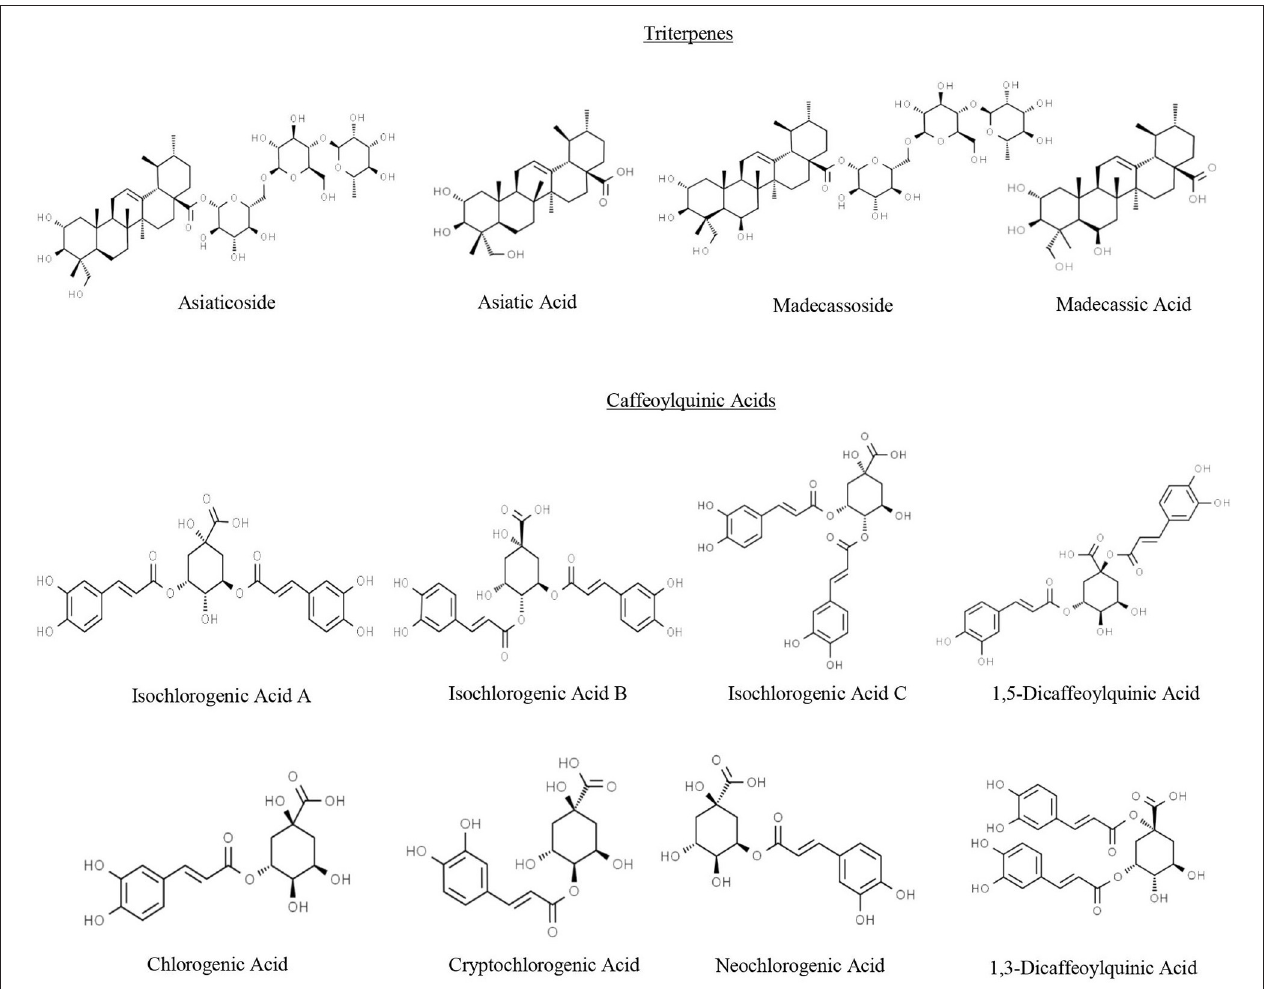
FIGURE 1 | Chemical structures of triterpenes and caffeoylquinic acids found in Centella asiatica . Structures were obtained from